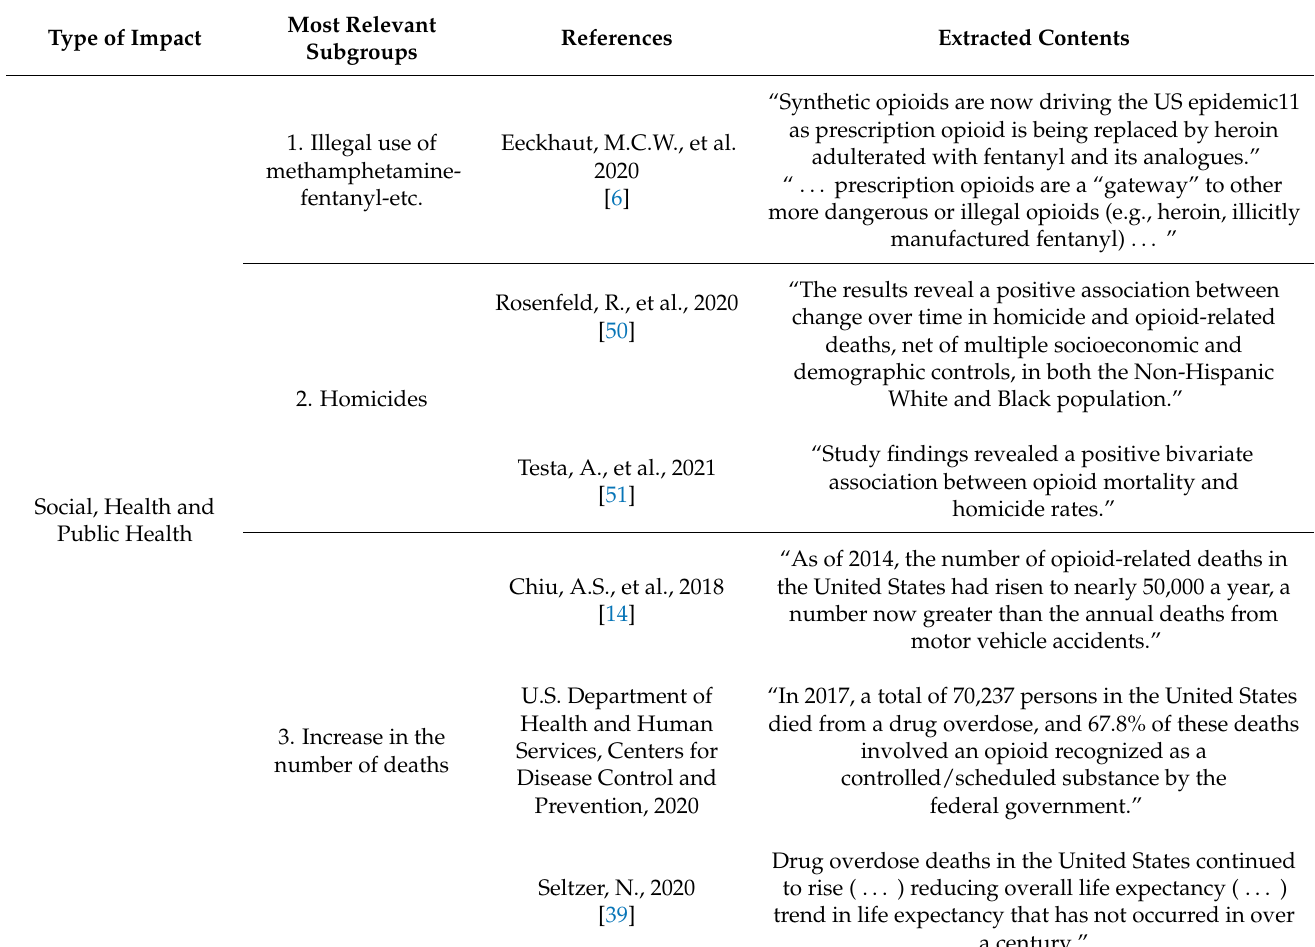
Table 3. Classification of the most relevant